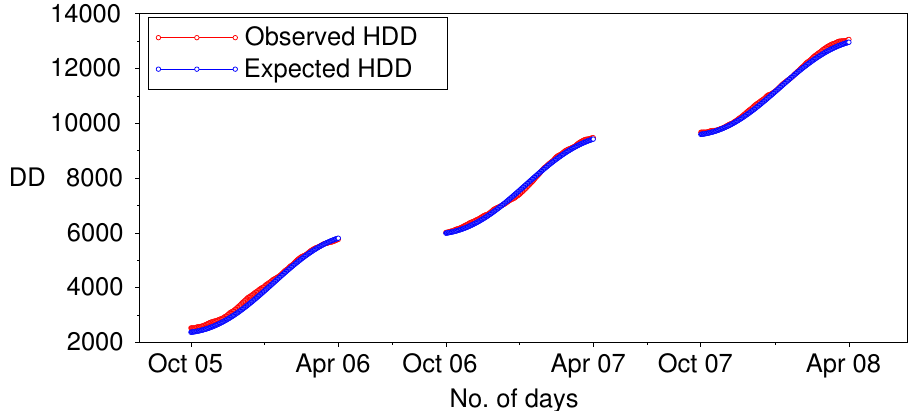
Figure 6. Plots of the observed HDD and expected HDD using (13) and the data from Section 3.4,